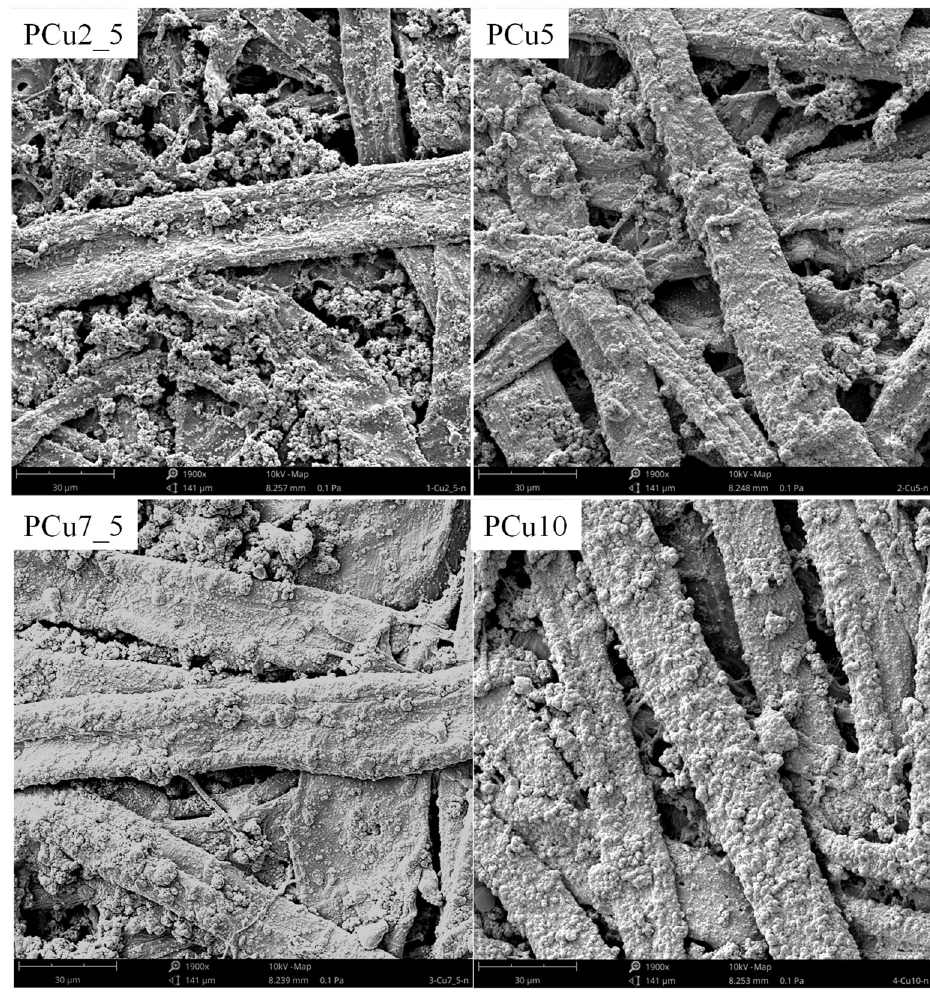
Figure 6. SEM surface images of metallized samples . Table 2. EDS analysis of the surface layer of metallized samples .